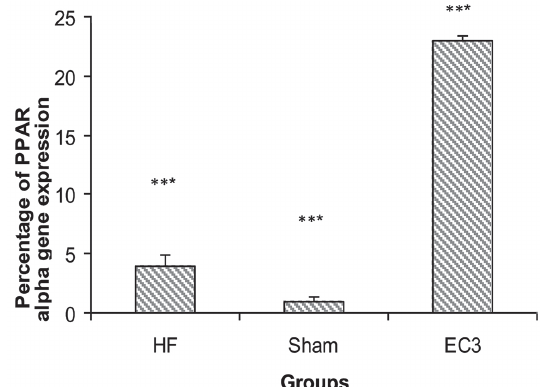
FIGURE 1 - Comparison of PPAR α gene expression between HF, Sham and EC3 with control. ***p<0.001 compared with